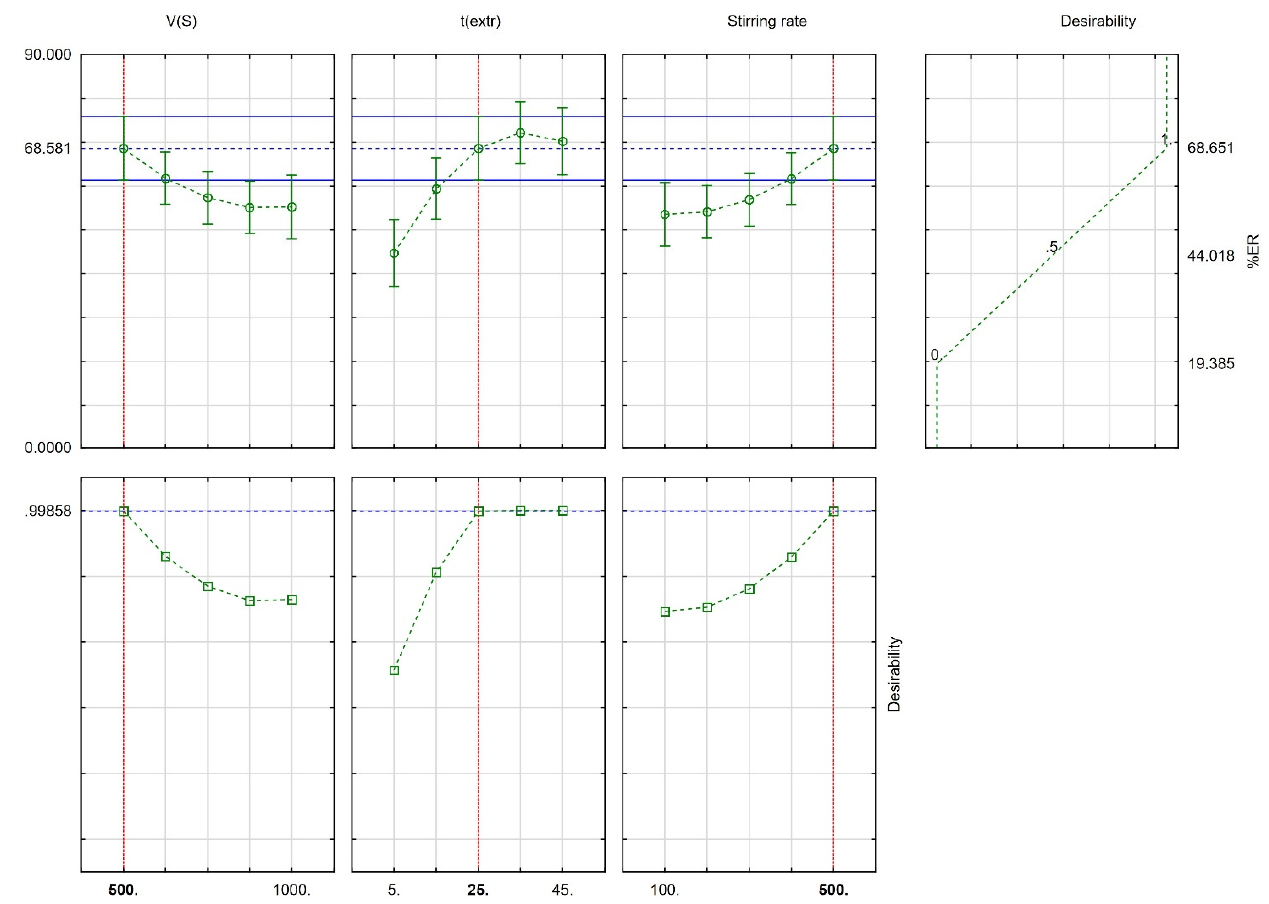
Figure 3. Profiles for predicted values and desirability function (red-colored lines designate the optimum value).